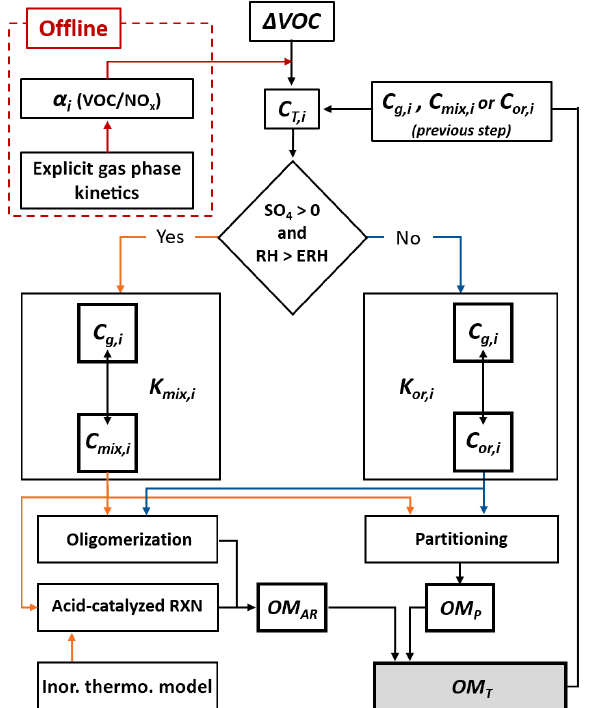
Figure 1. The overall schematic of the model applied to simulate isoprene SOA within UNIPAR. C T ,i is the total concentration of each lumping species, i , and C g ,i , C mix ,i and C or ,i are the con- centrations of each i within the gas, single homogenously mixed (SHMP) aerosol and organic-only aerosol, respectively. (cid:49) VOC is the consumption of the volatile organic compound of interest in each time step. α i is the stoichiometric mass ratio of each i , which is calculated offline as a function of VOC / NO x based on explicit gas phase simulations and is used to distribute the total (cid:49) VOC between each i . K mix ,i and K or ,i are the equilibrium partitioning coefficients for the SHMP and organic-only aerosol, respectively. OM T , OM P and OM AR are the total organic mass and the organic mass from aerosol phase reactions and partitioning,